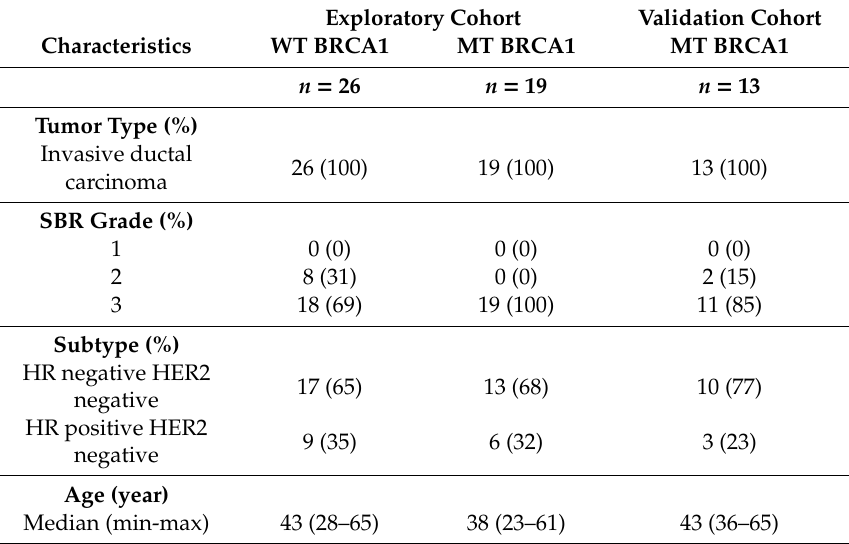
Table 1. Clinical and tumor characteristics of breast carcinoma tissues.